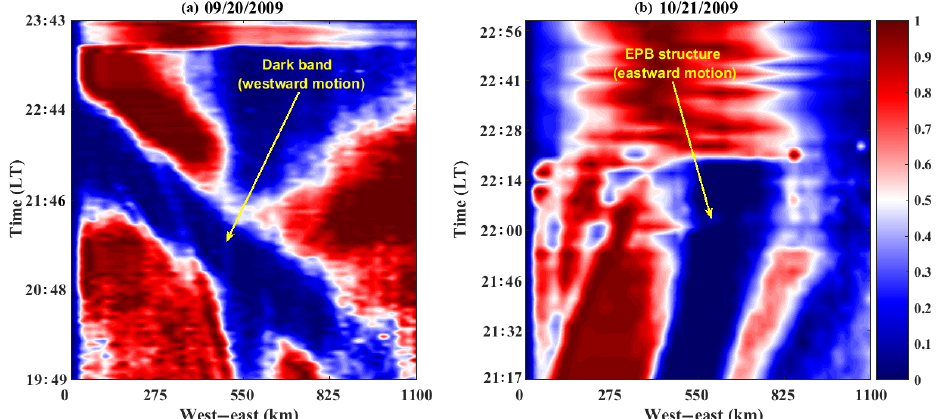
Figure 3. Keograms for 20 September 2009 (a) and 21 October 2009 (b) .